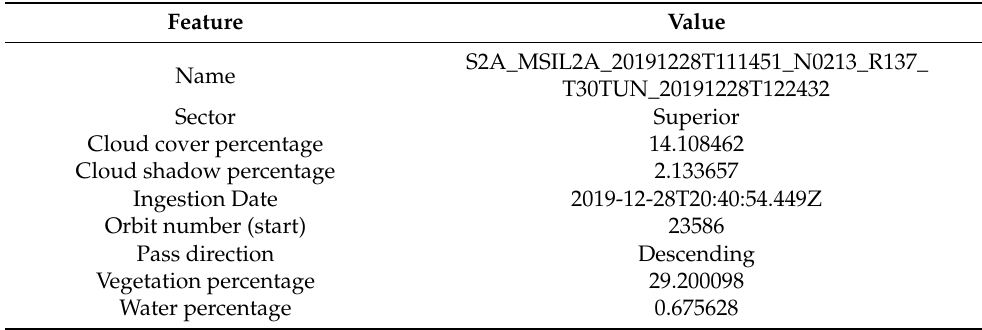
Table 1. Sentinel-2A image